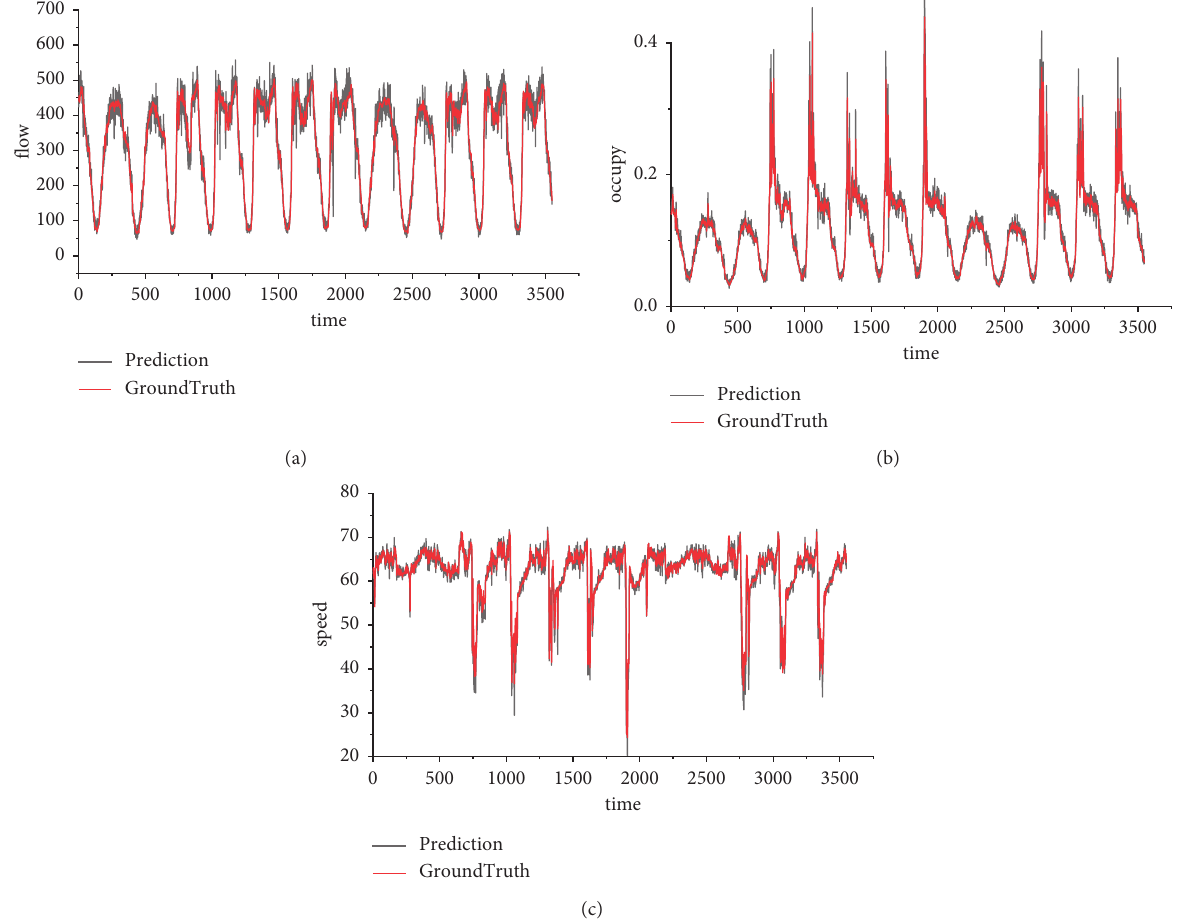
Figure 15: Comparison of the real values and predicted values for the three features on the PEMSD8 dataset. (a) Comparison of traffic flow. (b) Comparison of traffic occupancy. (c) Comparison of traffic speed.